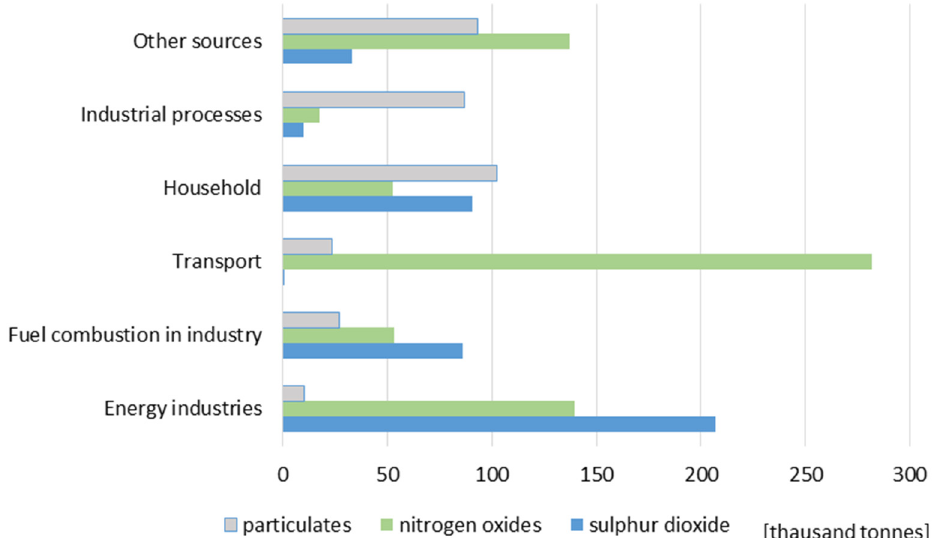
Figure 1. Balance of main air pollutants emission in Poland in 2019.